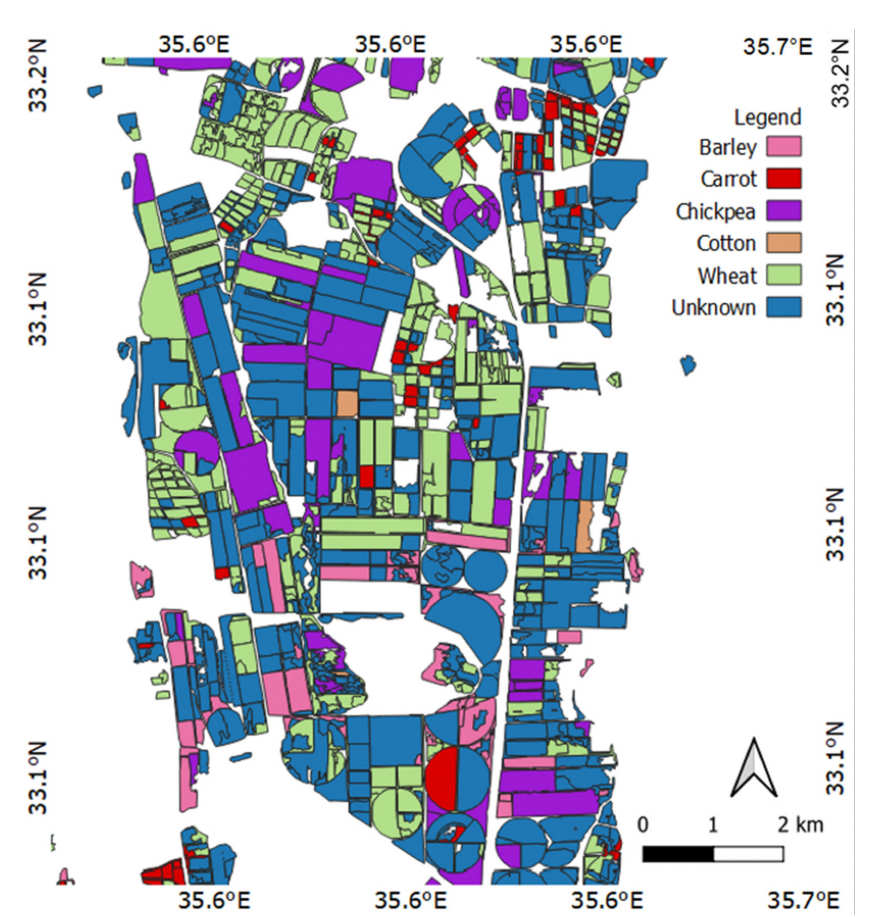
Figure 11. Final object-based NDII time series XGBoost classification results in a part of the study